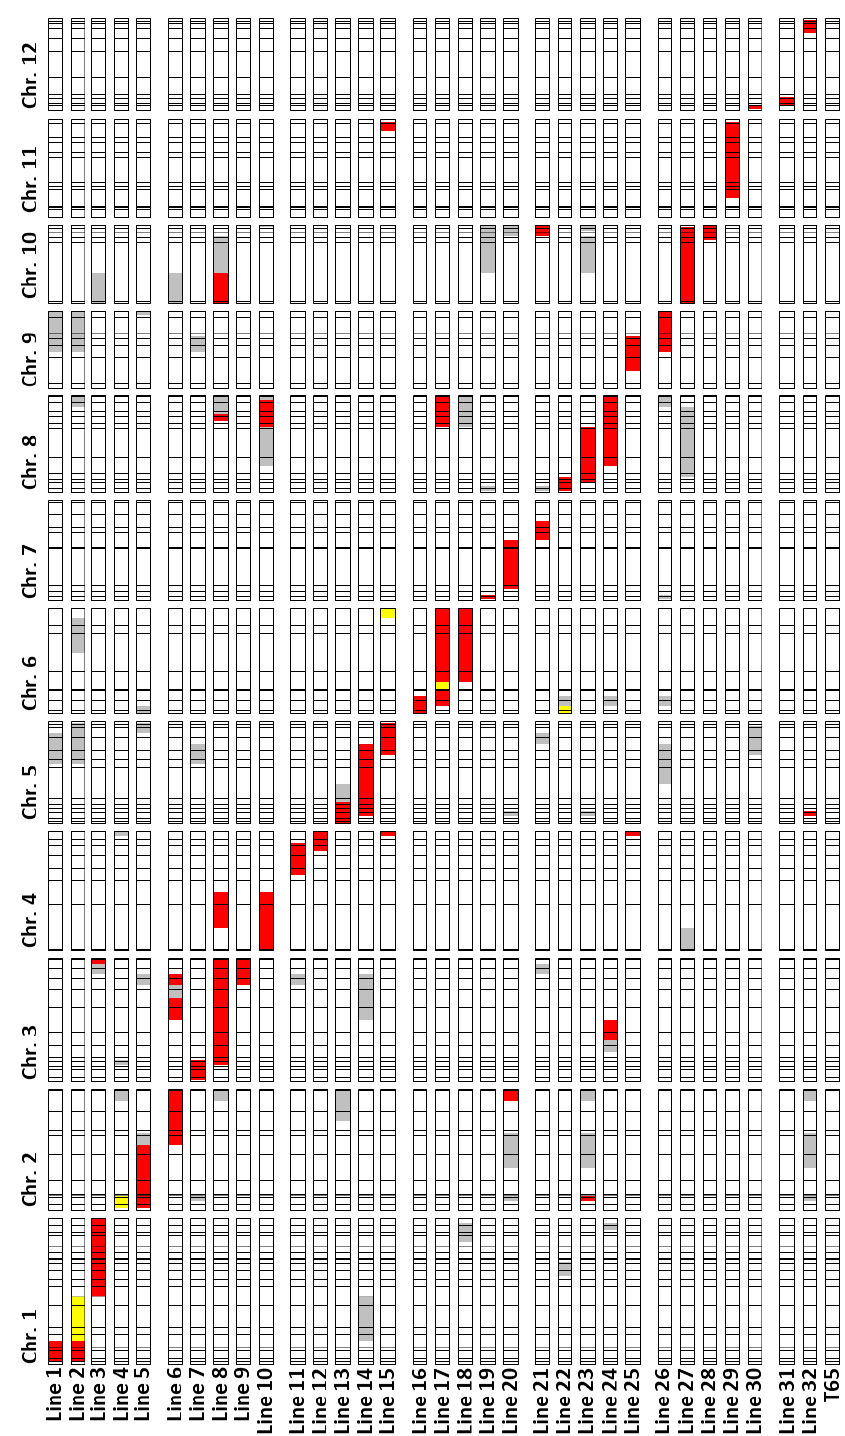
Figure 6. Construction of chromosome segment substitution lines of O. longistaminata accession W1508 (W1508ILs) in the genetic background of O. sativa L. cv. Taichung 65. Red and white boxes represent homozygous genotypes for W1508 and Taichung 65 alleles, respectively. Yellow boxes represent heterozygous genotypes. Missing genotypes at markers showing heterozygous genotypes at BC 3 F 1 generation are indicated by